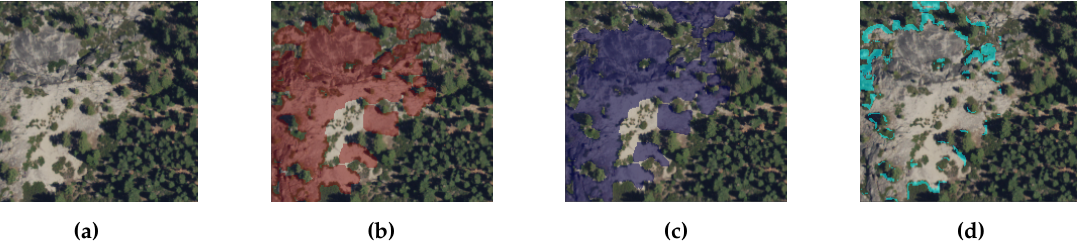
Figure 7. Comparison of initial labels to KNN-improved labels. ( a ) NAIP imagery from ELD2 tile; ( b ) initial bedrock mapping in red; ( c ) KNN-refined label in blue; ( d ) difference between initial and KNN labels in light